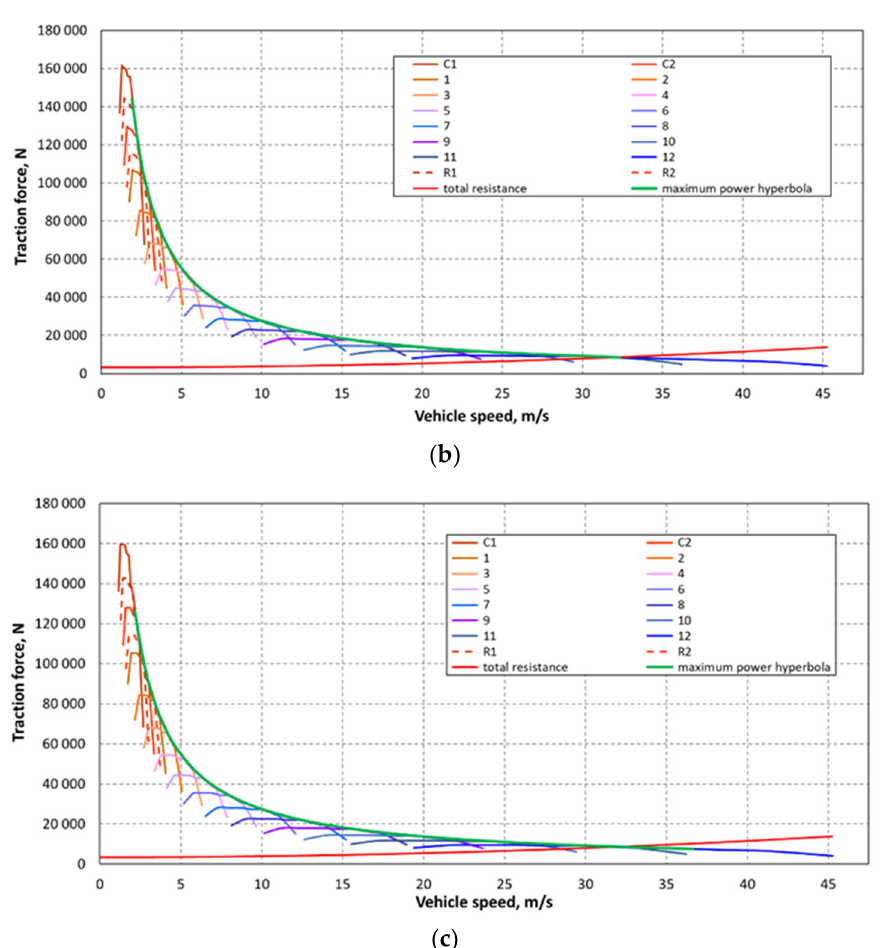
Figure 6. Tractive effort curves determined for: ( a ) factory data, ( b ) diesel fuel and ( c ) diesel/CNG.